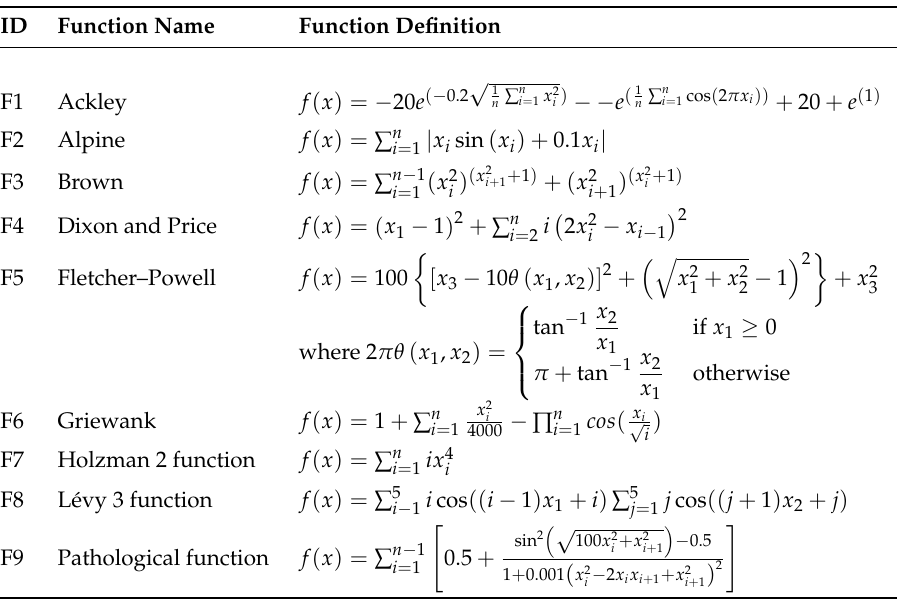
Table 2. Benchmark function